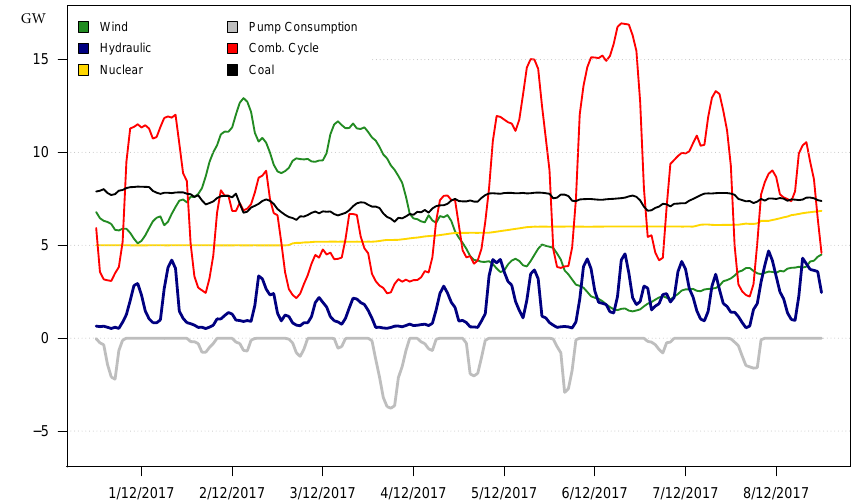
Figure 9. A low VRES period in December 2017. Source: authors based on the REE data